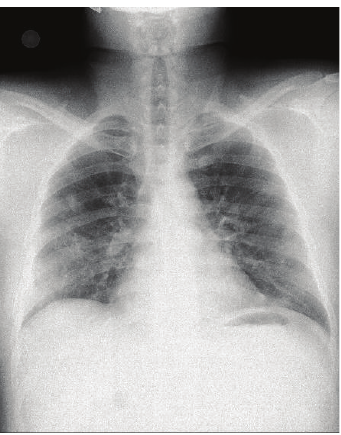
Figure 5: Regression of nodular lesions at the postoperative 2nd month follow-up chest X-ray following